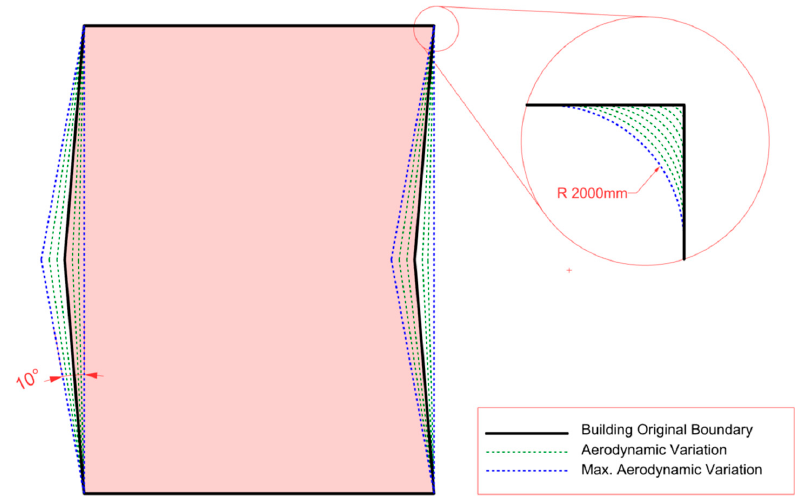
Figure 9. Aerodynamic modification parameters.